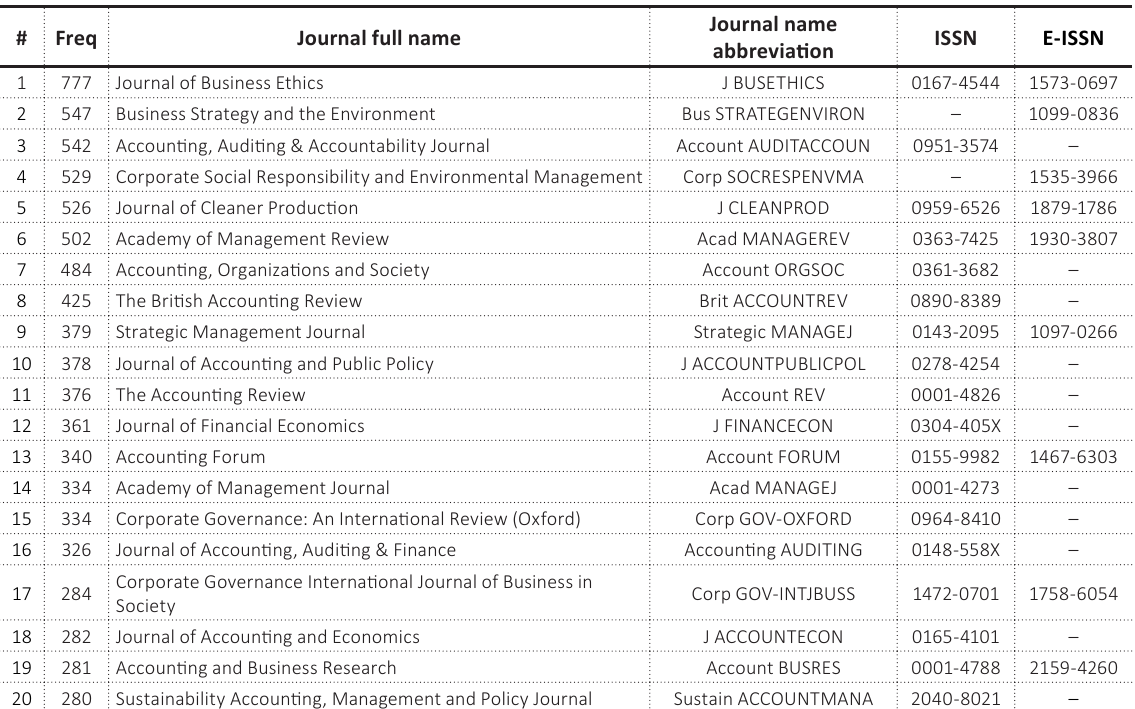
Table 4. Statistics of cited